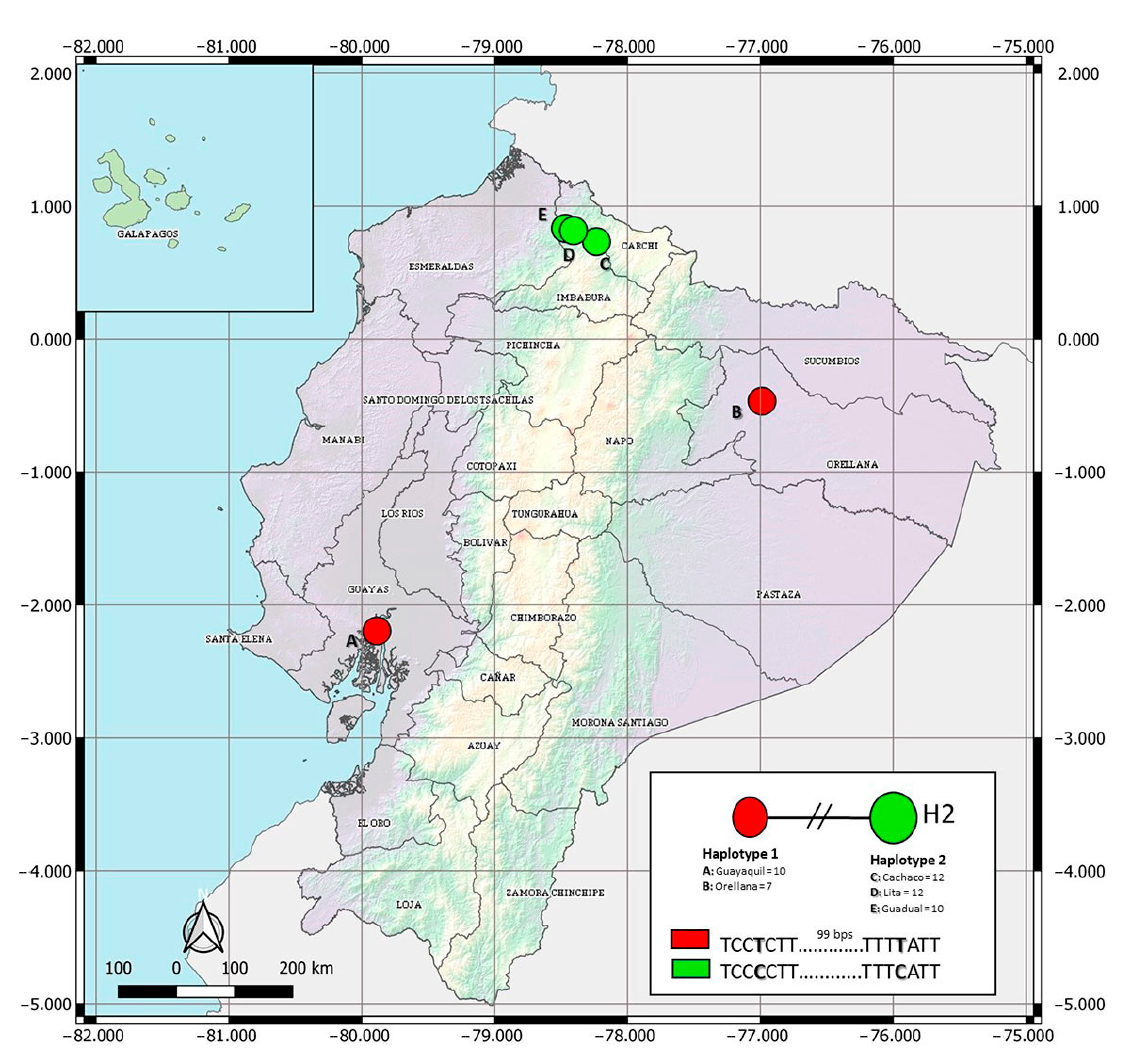
Figure 2. Haplotype network of the COI gene for Ecuadorian samples of Aedes albopictus . H1 represents 17 sequences, 10 from Guayaquil and 7 from Orellana. H2 represents 34 sequences, 12 from Cachaco, 12 from Lita, and 10 from Guadual.